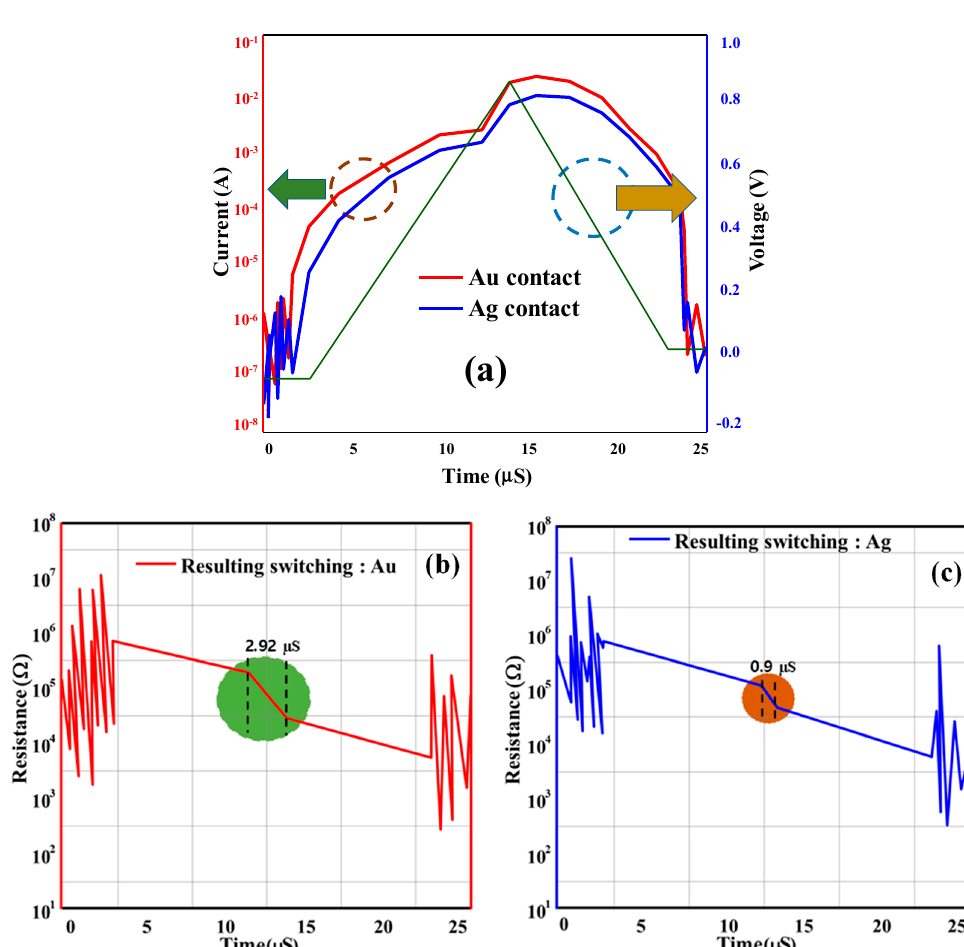
Figure 4. Comparative devices performances ( a ) I–V–t curve for both Au/TiO 2 NPs and Ag/TiO 2 NPs.